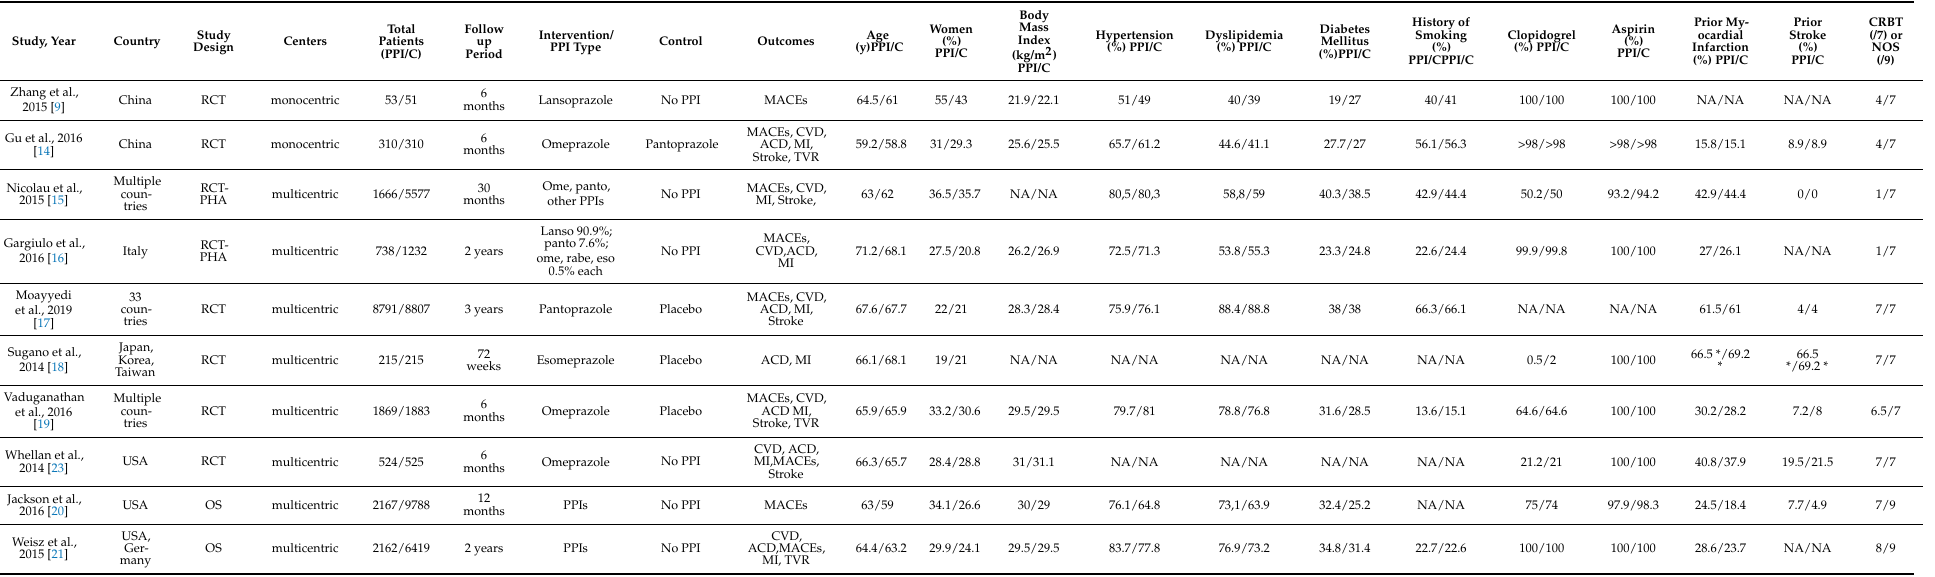
Table 1. Study characteristics and patients’ characteristics at